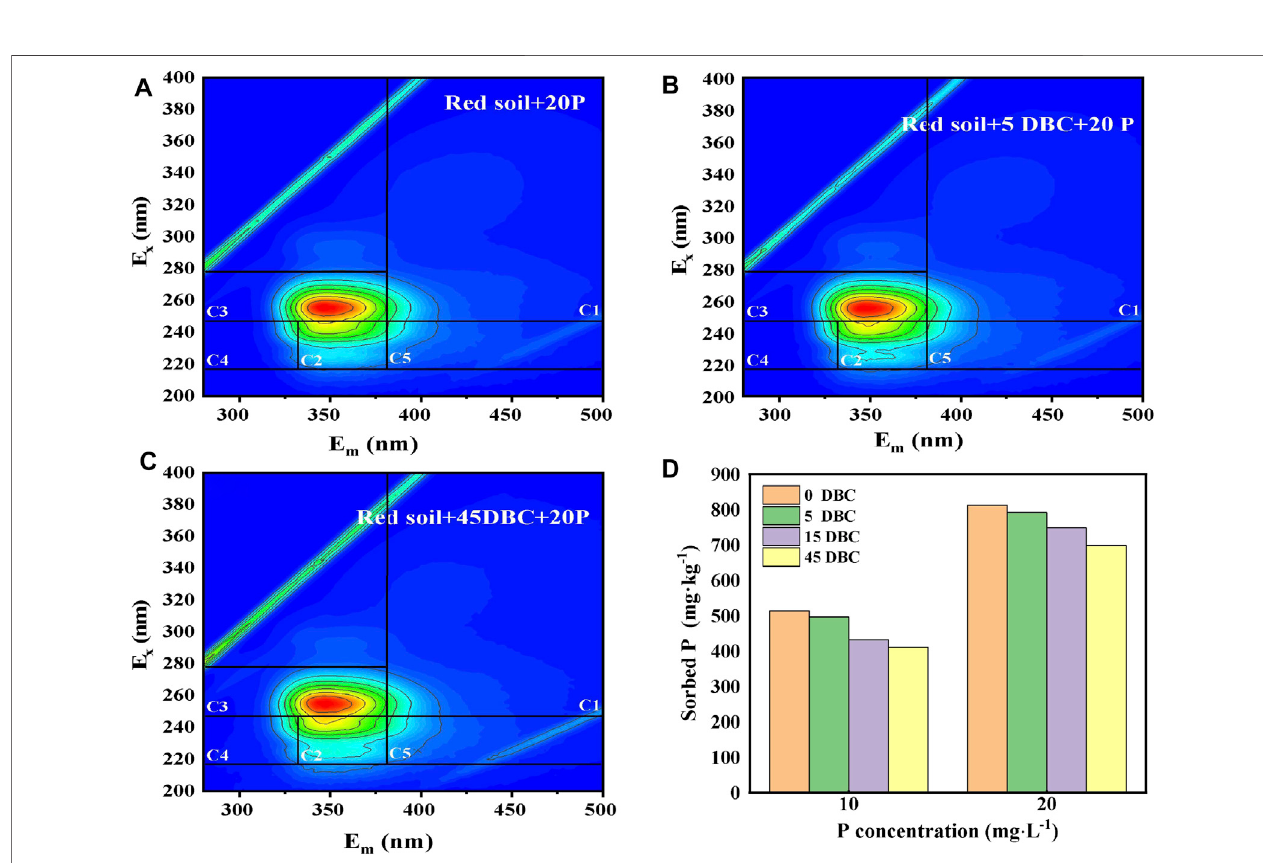
FIGURE6| 3D-EEMofthedissolvedorganicmatterinthephosphorusadsorptionequilibriumsolutionbytheDBC(0,5,or45 mgL − 1 )-amendedredsoils (A – C) ;P absorption capacity of the DBC-amended red soils (D)